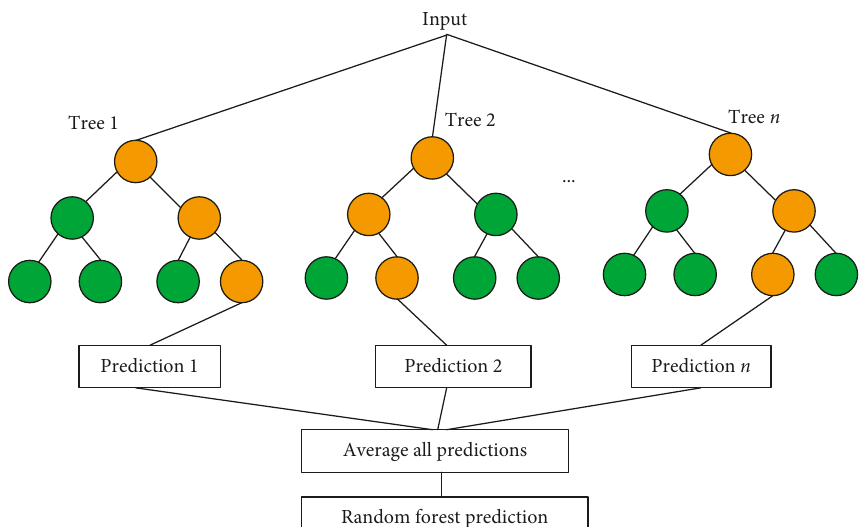
Figure 1: General structure of the RF model.